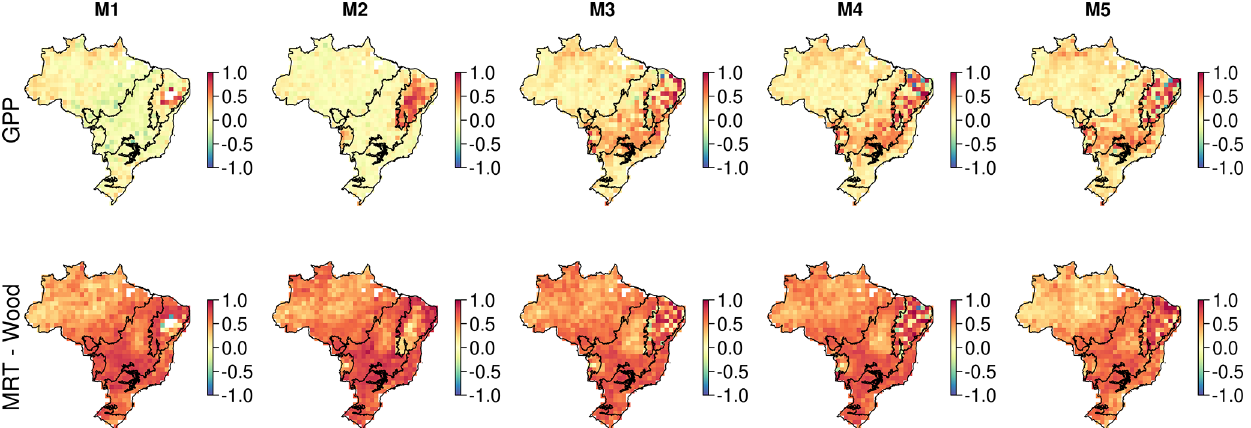
Figure 8. Correlation maps between the simulated change in biomass stocks (SSP2-4.5; 2001–2100) and ecosystem variables. These maps identify spatial variation in the sensitivity of biomass change to key ecosystem variables. Correlates are wood MRT (years) and GPP (gCm − 2 d − 1 ) estimated across the whole simulation period.